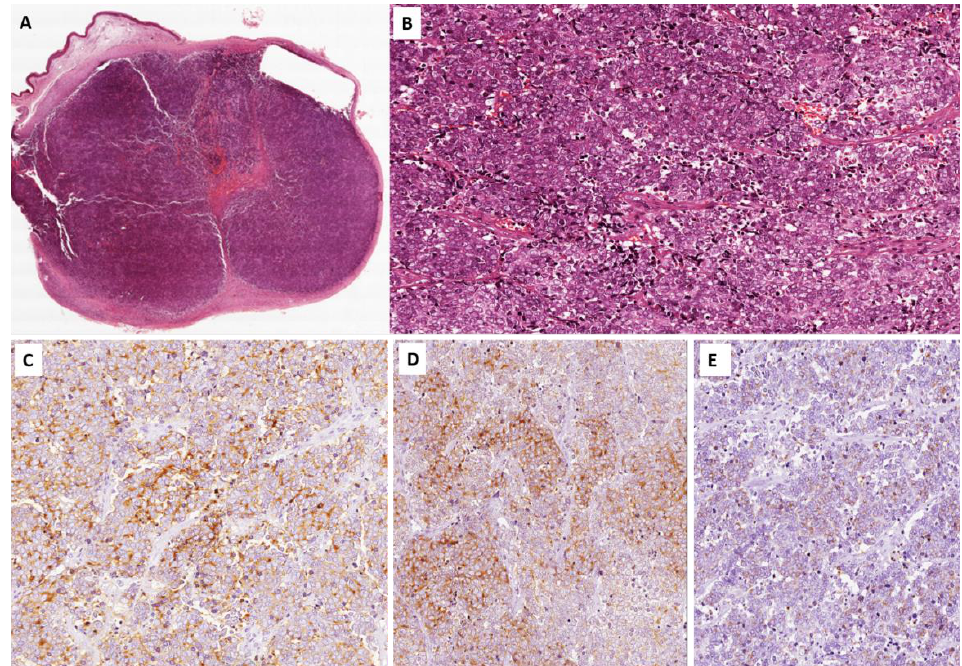
Figure 1. Merkel cell carcinoma. ( A ) Histological examination showing a tumor nodule involving the dermis. ( B ) Higher magnification showing a malignant tumor composed of small- to medium-sized round cells with vesicular nuclei showing “salt and pepper” appearance. Neoplastic cells showing cytoplasmic immunoreactivity for chromogranin A ( C ), synaptophysin ( D ), and cytokeratin 20 ( E ).